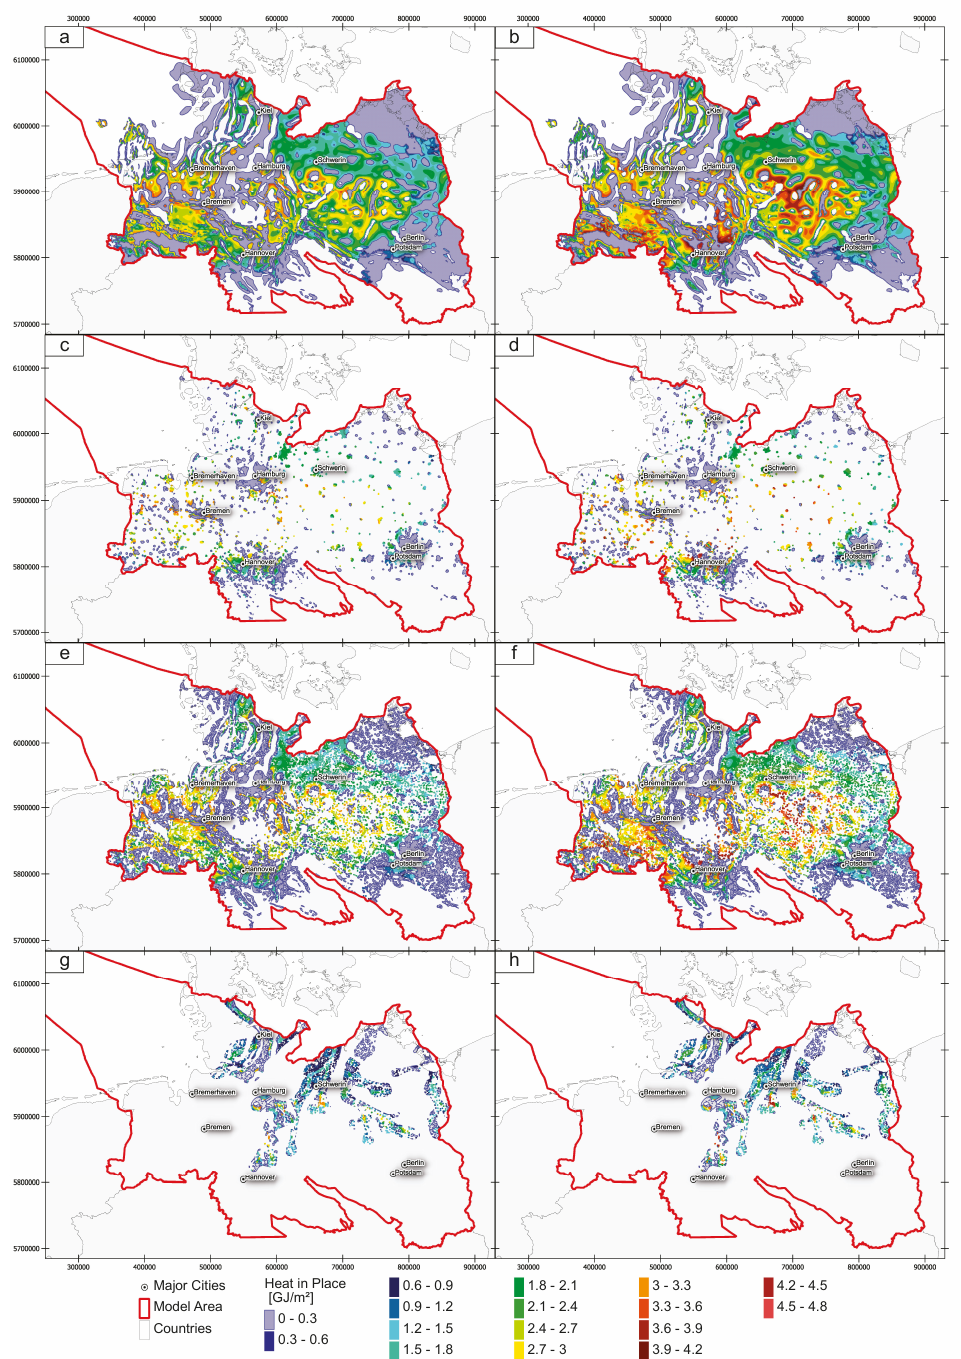
Figure 5. Calculated heat in place ( HIP ) for the Upper Keuper and Upper Exter Formation: ( a ) HIP with CEBS temperature data [32]; ( b ) HIP with GeotIS temperature data [46]; ( a , b ) Blank areas = reservoir not present; ( c ) HIP of the Upper Keuper in densely populated areas after ( a ); ( d ) HIP of the Upper Keuper in densely populated areas after ( b ); ( e ) HIP of the Upper Keuper in areas of high heating demand after ( a ); ( f ) HIP of the Upper Keuper in areas of high heating demand after ( b ); ( g ) HIP of the Upper Exter in areas of high heating demand with CEBS temperature data [32]; ( h ) HIP of the Upper Exter in areas of high heating demand with GeotIS temperature data [46]; ( a – f ) Color-coding and symbology indicated at the bottom. Coordinates are in UTM Zone